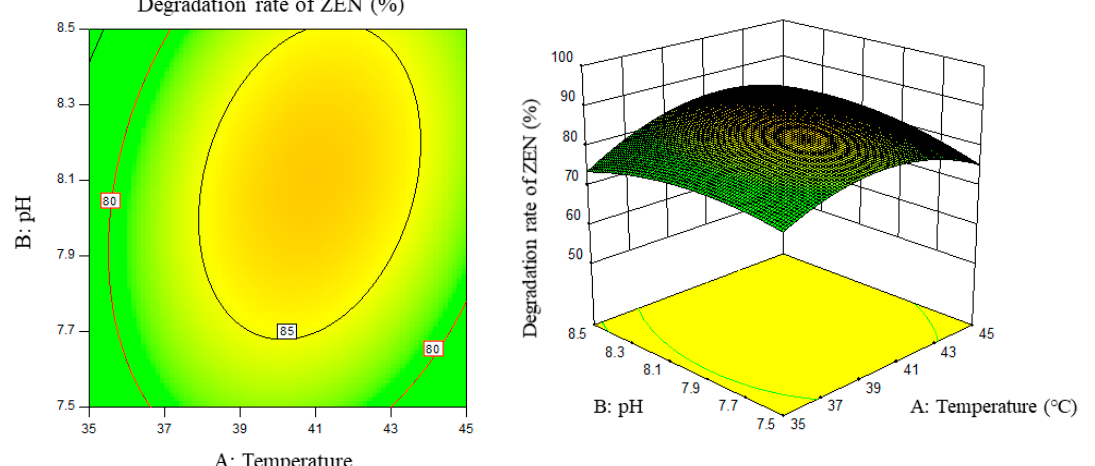
Figure 5. Temperature, pH, and their interaction vs. the response surface and contour line of the degradation rate of ZEN.